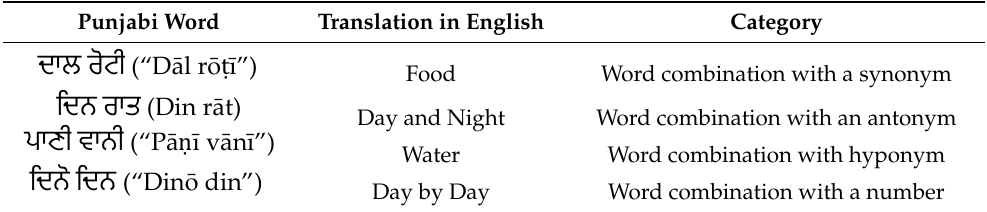
Table 4. Combination of Punjabi words with their synonym, antonym, hyponym, or number.